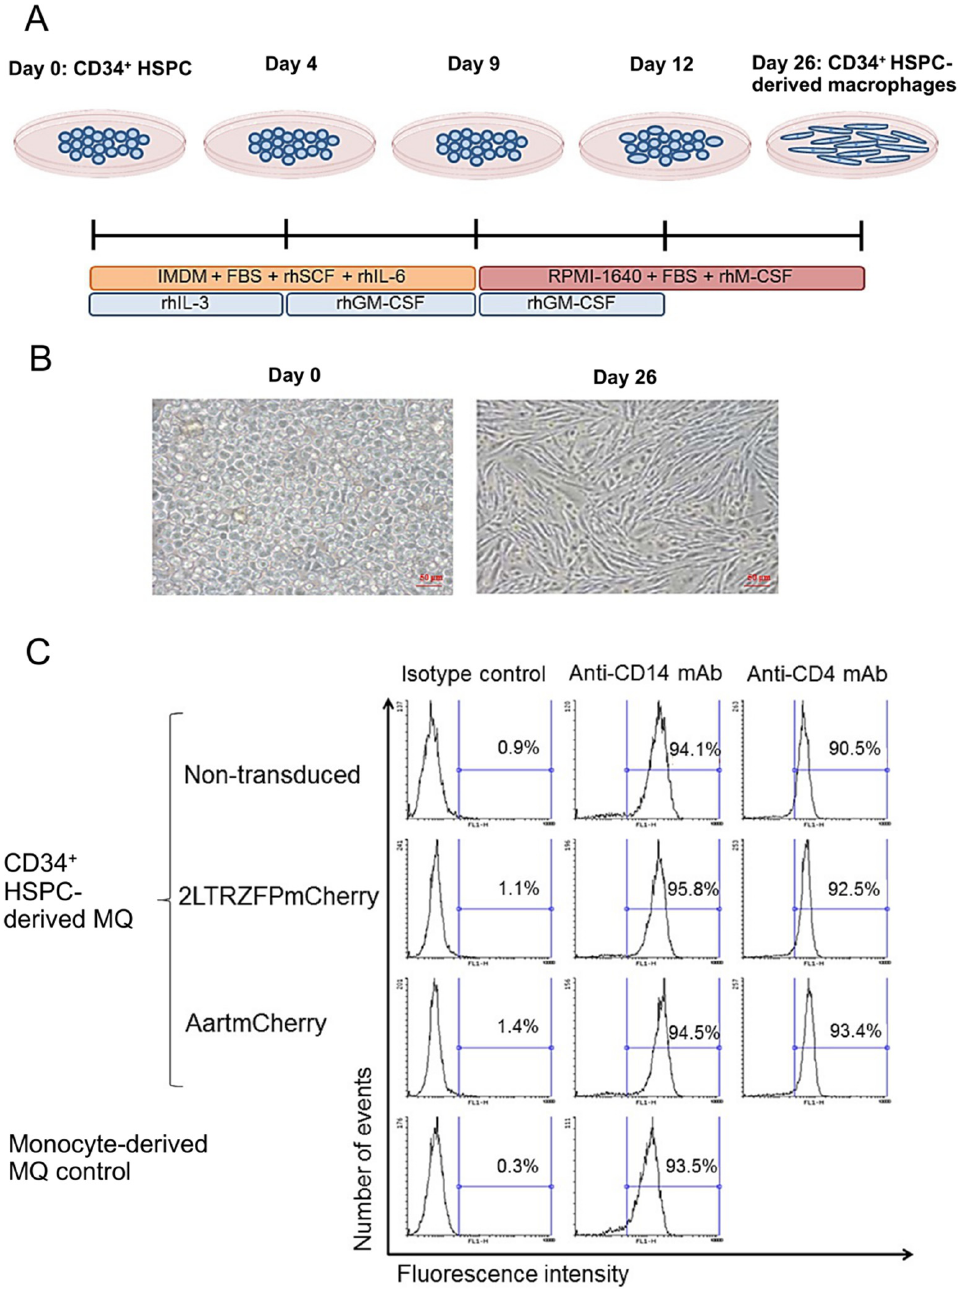
Figure 3 . Differentiation of CD34 + HSPCs into macrophages. ( A ) The schematic timeline shows the differentiation of CD34 + HSPCs into macrophages. ( B ) The morphological changes of the CD34 + HSPCs in each stage of differentiation. ( C ) Representative flow cytometric analysis of CD14 and CD4 on the transgenic CD34 + HSPC-derived macrophages and the PBMC monocyte-derived macrophages. MQ = macrophage (s).